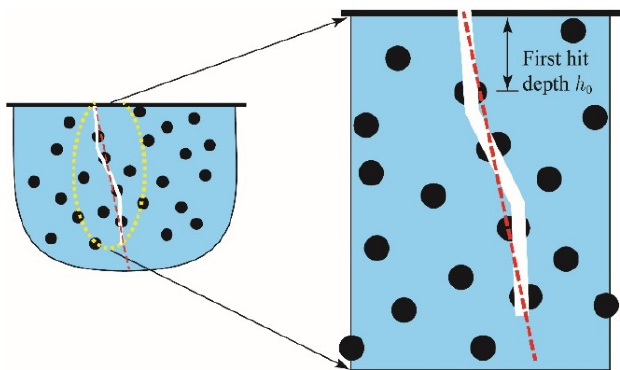
Figure 3. Depth of first hit measured from the top surface.